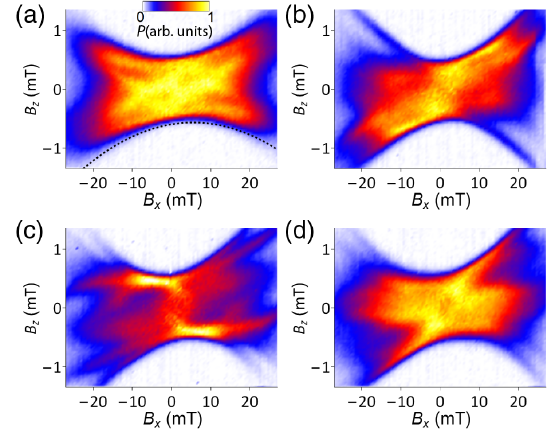
FIG. 5. (a) – (d) Intensity maps of the integrated magnetization R S ð ν Þ d ν versus in-plane and out-of-plane applied noise P ¼ field ( B x , B z ), at room temperature (295 K). The four panels are acquired at slightly different locations on the Pt = Co = Pt film, separated by < 10 μ m. The bow-tie shape of these images is determined by the balance between the fixed thermal energy k B T and the field-dependent energy required to spontaneously form magnetic domains (see text). The very different patterns within each bow tie, and the lack of reflection symmetry about the B ¼ 0 axes, reveal a spatially varying magnetic anisotropy that x;z is canted slightly away from perfectly out of plane. Dashed line in (a) shows a quadratic fit to the edge of the bow magnetization m z saturates along (cid:3) ˆ z , which was defined in Fig. 4 as B z ¼ B for the case when B x ¼ 0 . sat